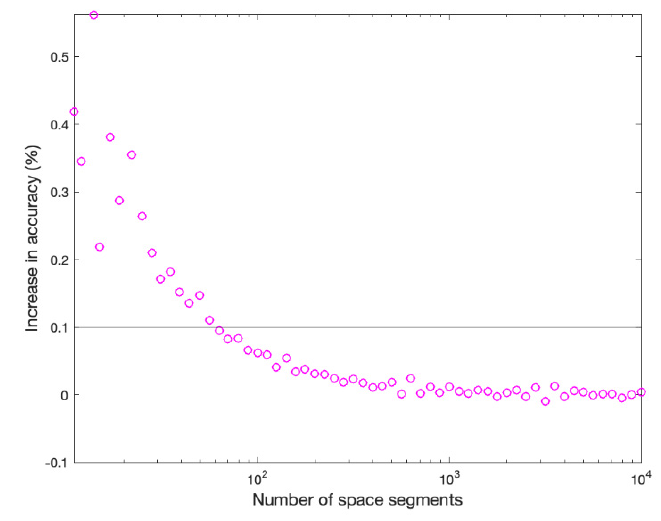
Figure A1. UFC lifetime and computation time for different number of spatial segments.